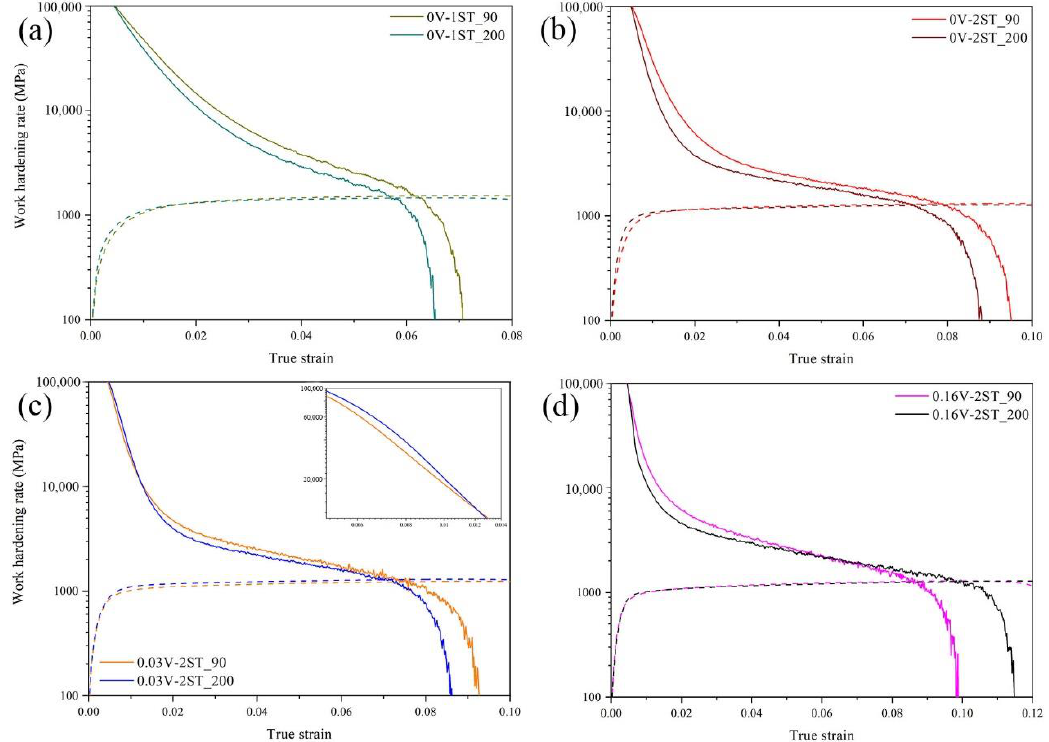
Figure 15. Work hardening rate as a function of true strain (solid line) along with the corresponding true strain–stress curve (dotted line) of specimens: ( a ) 0V-1ST, ( b ) 0V-2ST, ( c ) 0.03V-2ST, and ( d ) 0.16V-2ST.